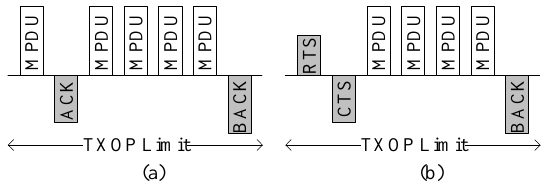
Figure 2. Proposed block ACK (BA) in ( a ) basic access mode and ( b ) RTS/CTS access